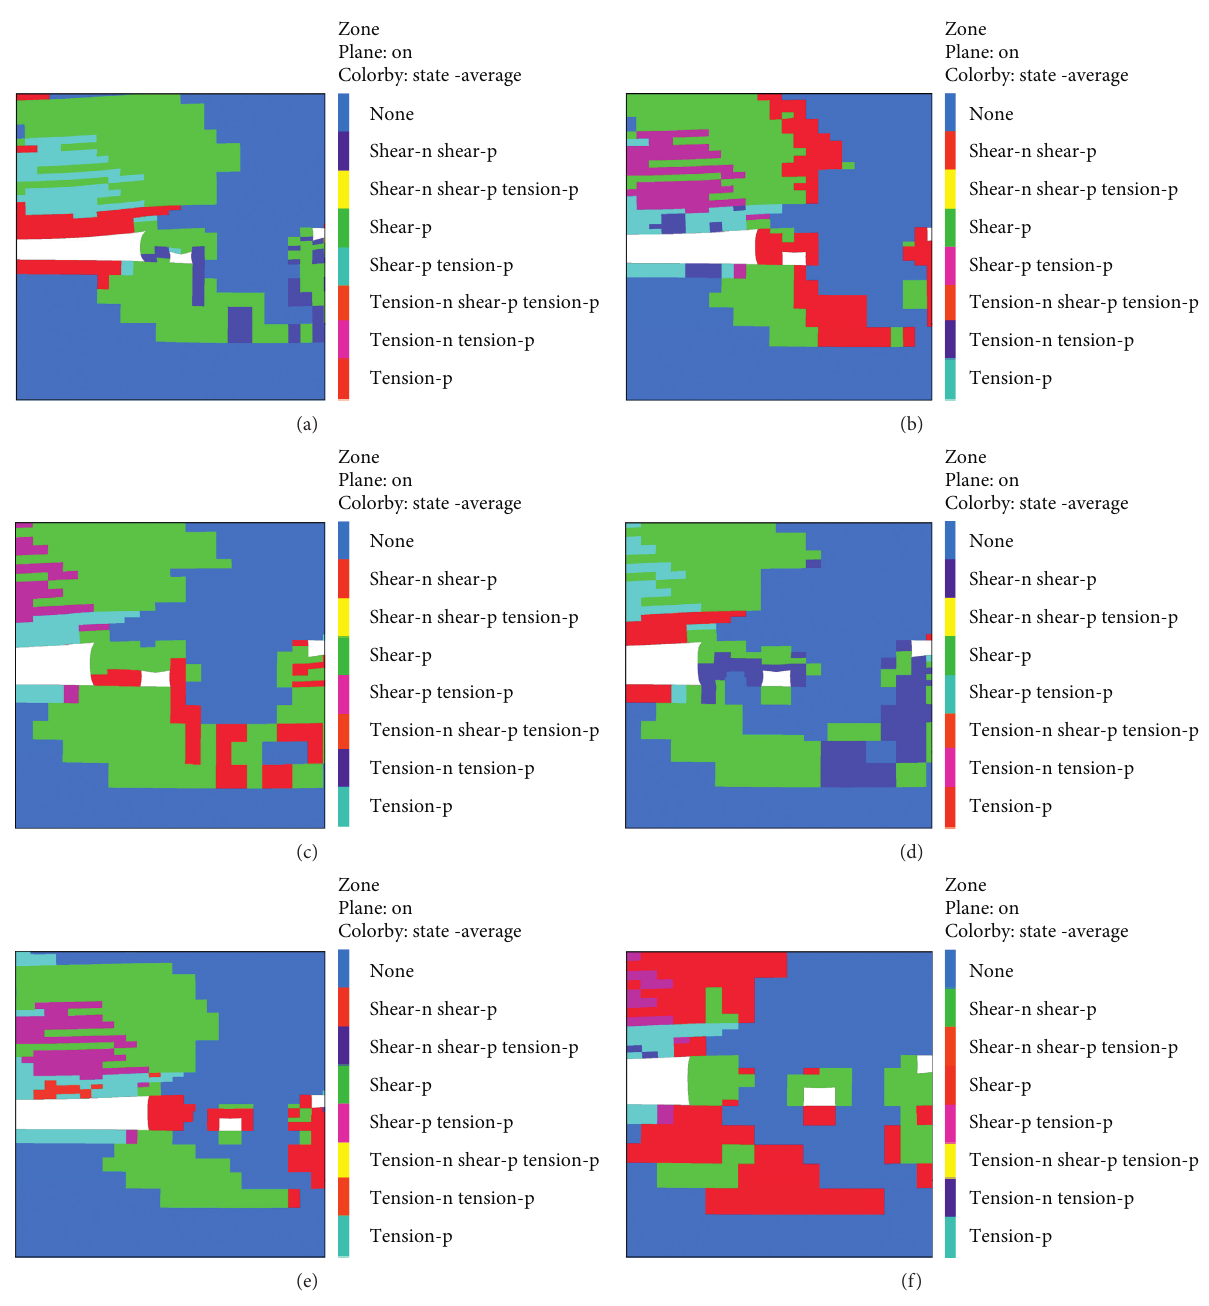
Figure 16: Distribution map of coal pillar plastic zone in different width sections: (a) 4m, (b) 5m, (c) 8m, (d) 10m, (e) 13m, and (f)